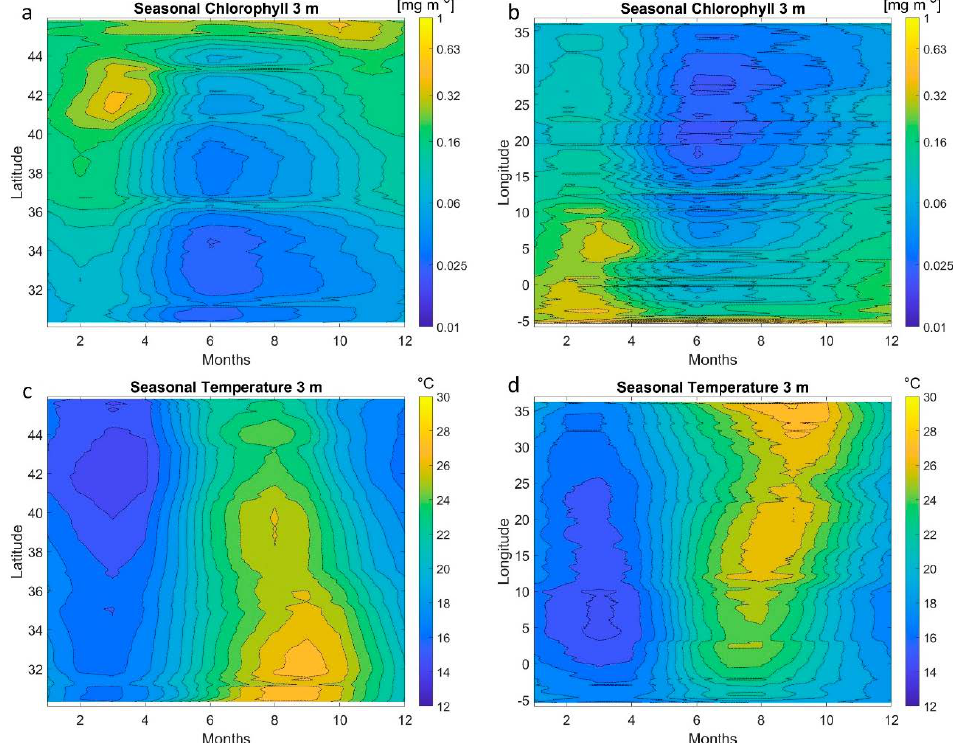
Figure 12. An example of MLP basin reconstruction from monthly satellite data at 3 m of depth. On the left panels a contour plot of the longitudinal chlorophyll ( a ) and temperature ( c ) means along the year (on x-axis) is shown. On the right, a corresponding contour plot of latitudinal chlorophyll ( b ) and temperature ( d ) means is provided.